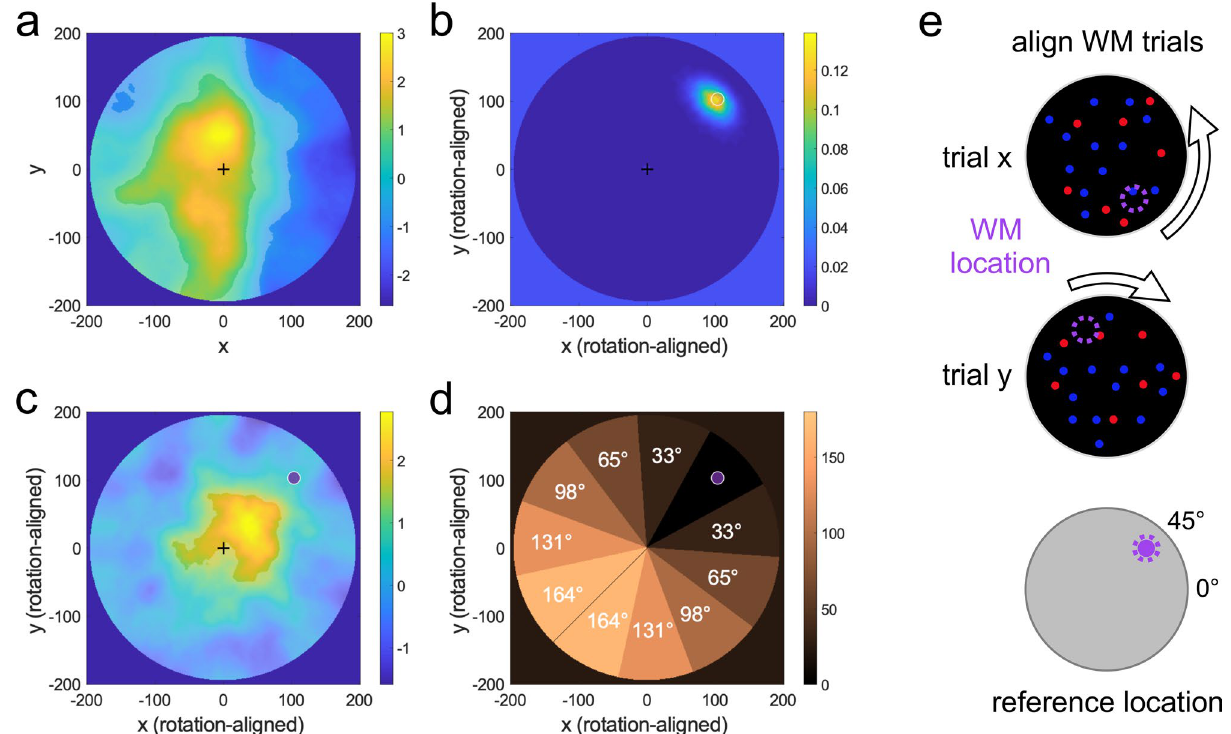
Figure 2. Spatial weighting analysis. ( a ) Spatial weighting of the decision displays before rotational alignment, collapsed across all trials (WM and control conditions) and displays (1–6). Positive values indicate overweighting, negative values underweighting, relative to an unbiased observer model fitted to each individual (see “Methods”). Transparent mask indicates significant regional over- or underweighting ( p < 0.05, two-tailed, FDR-corrected across pixels). ( b ) Spatial distribution of WM sample positions reported on WM recall (cf. Fig. 1a, right ) after rotational alignment (cf. e ), aggregated across all participants. White circle indicates true position (rotation-aligned) of the WM sample. ( c ) Spatial weighting on WM trials after rotational alignment (cf. e ), same conventions as in b. Purple dot indicates (rotation-aligned) location of the WM sample. ( d ) Pie masks for angular tuning analysis. Spatial weights within each segment were averaged and examined as a function of the absolute angular distance from the WM sample (see Fig. 3b below for results). ( e ) Rotational alignment of trials. Displays were rotated offline such that the trial-specific WM sample positions matched the same (virtual) reference location (arbitrarily set to 45°, cf. purple